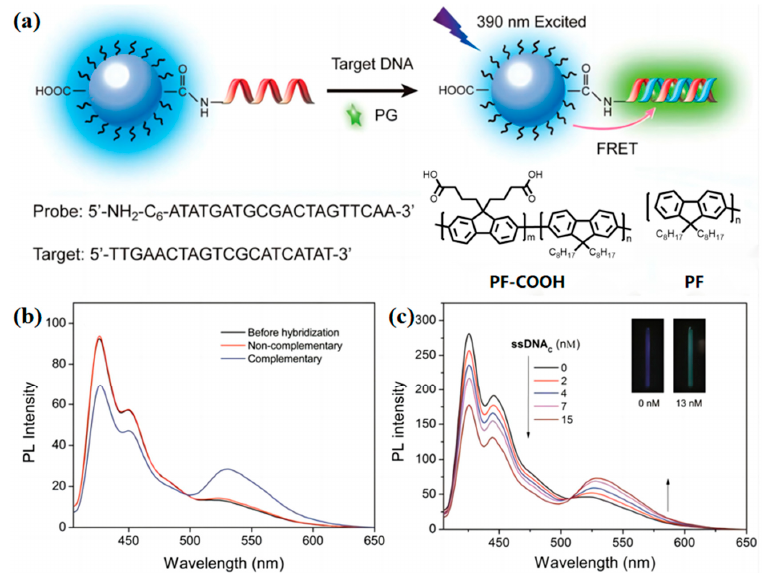
Figure 6. ( a ) Schematic illustration of the PF-DNAP CPNs for label-free DNA detection. Adapted with permission from [80]. ( b ) PL change in PF-DNAP CPNs/PG before and after hybridization be- tween complementary target ssDNAC and non-complementary ssDNANC in HEPES containing 10 vol% serum. [ssDNAC] = [ssDNANC] = 8 × 10 − 9 M. Adapted with permission from [80]. ( c ) PL spec- tra of PF-DNAP CPNs/PG in the presence of ssDNAC with [ssDNAC] ranging from 0 to 15 nM in HEPES containing 10 vol% serum. Insets: fl uorescence photographs of PF-DNAP CPNs/PG with and without ssDNA C . λ ex = 390 nm. Adapted with permission from [80].